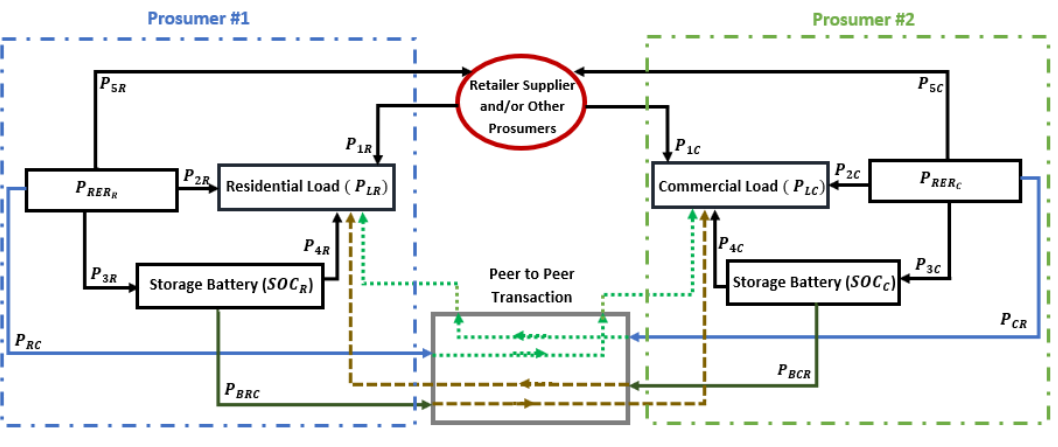
Figure 2. Coupled microgrid block diagram with two